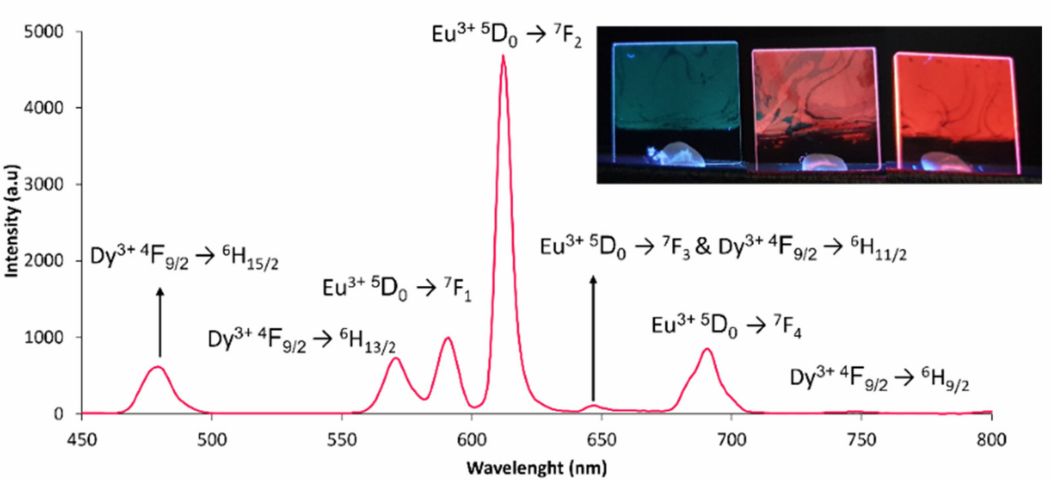
Figure 4. Mixed multilayered Eu( 1 ) 3 :Dy( 1 ) 3 LB film fluorescence spectrum showing both distinct Ln 3+ emission transitions. Insert: Eu( 5 ) 3 :Dy( 5 ) 3 mixed multilayered film in the centre with a monolayer Dy( 1 ) 3 film on the left and Eu( 1 ) 3 on the right under shortwave UV irradiation ( λ ex = 254 nm).